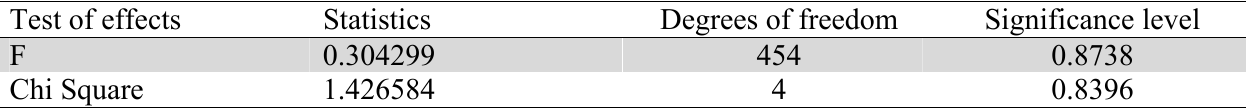
Chow test results for firms with low life cycle score